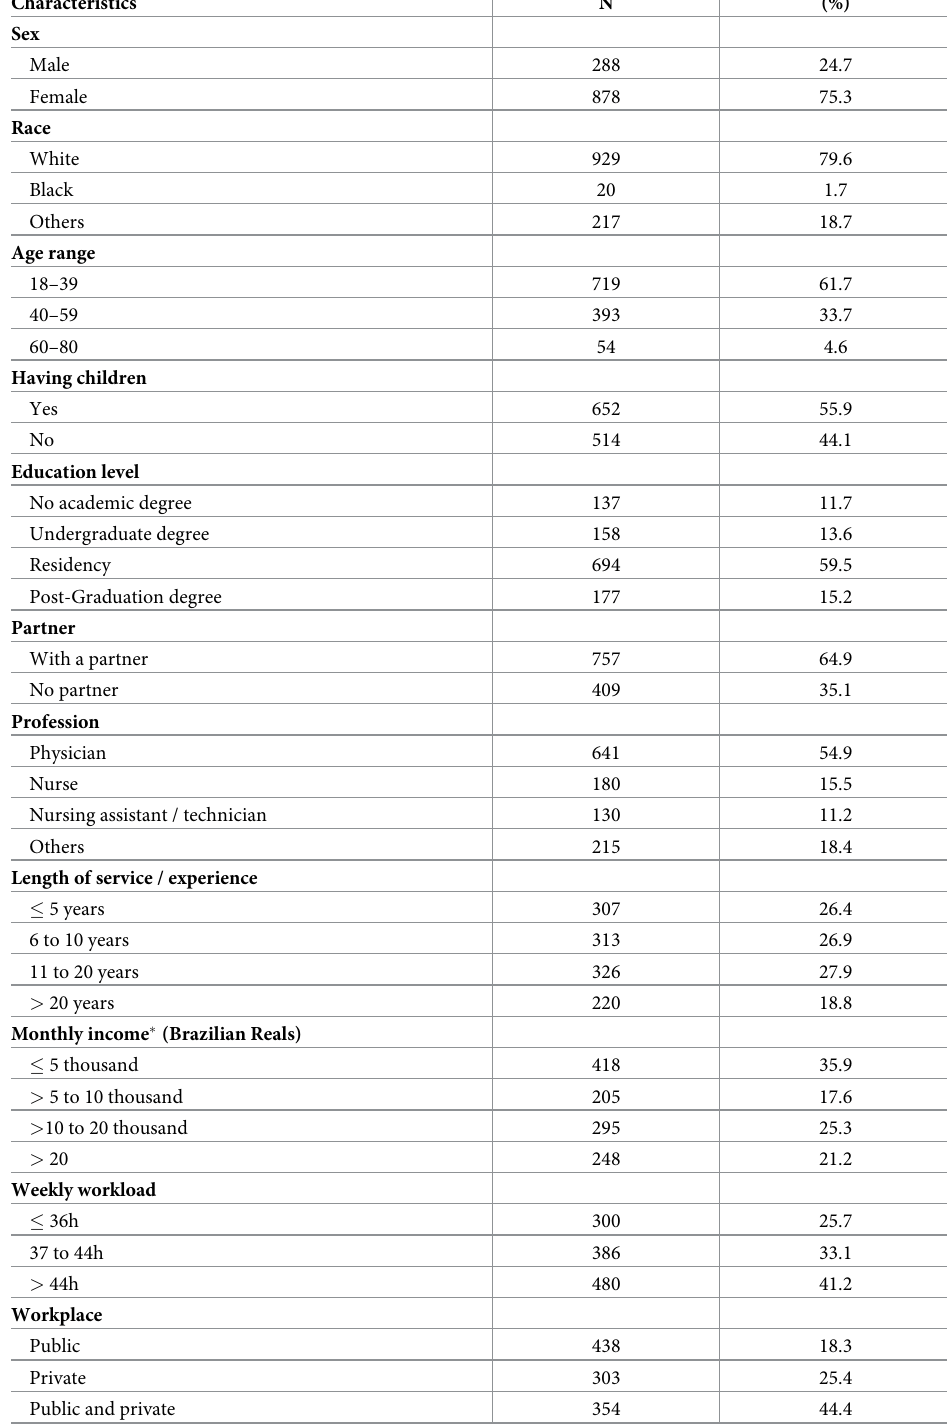
Table 2. Sociodemographic and professional characteristics of the research